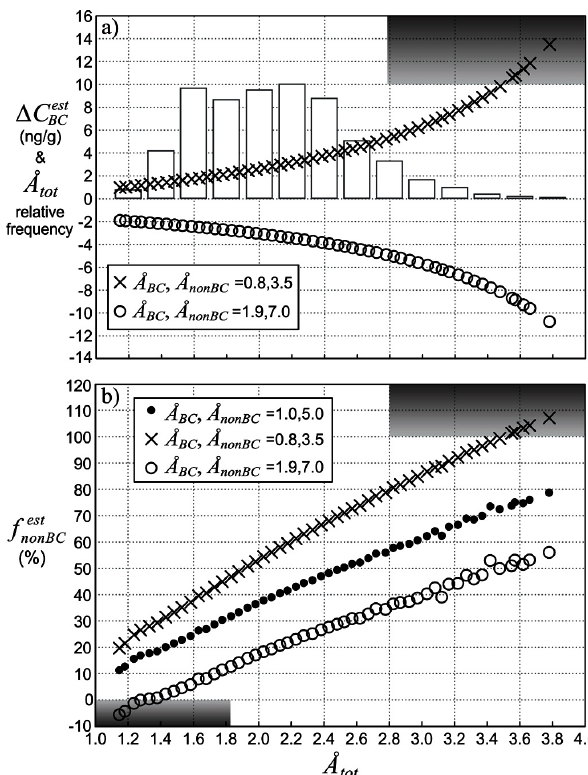
Fig. 16. Sensitivity of derived values to uncertainty in the assumed absorption ˚Angstrom exponents for BC and non-BC. The values used in the analysis were ˚A BC = 1 . 0 and ˚A nonBC = 5 . 0. (a) Error in C est (ngg − 1 ) as a function of the measured absorption ˚Angstrom BC exponent from the filter, ˚A tot , when C est = 10ngg − 1 and the true BC values of ˚A BC and ˚A nonBC are lower (0.8 and 3.8, respectively) or higher (1.2 and 7.0, respectively) than the values assumed in the analysis. Also shown is a histogram of the relative frequency of occurrence of ˚A tot in our sample data set. (b) Inferred percent of absorption due to non-BC absorbers, as obtained using three differ- ent sets of assumptions for absorption ˚Angstroms. Values shown in both frames are calculated from all the samples included in Sect. 5, averaged into bins of ˚A tot . Shaded regions indicate values that are < 0, f est < 0%, f est > physically impossible ( C est BC nonBC nonBC